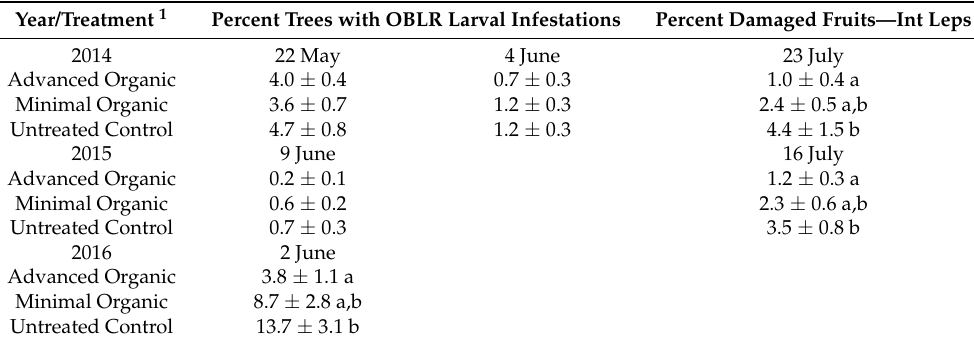
Table 2. Obliquebanded leafroller and fruit-feeding Lepidoptera in-season damage.